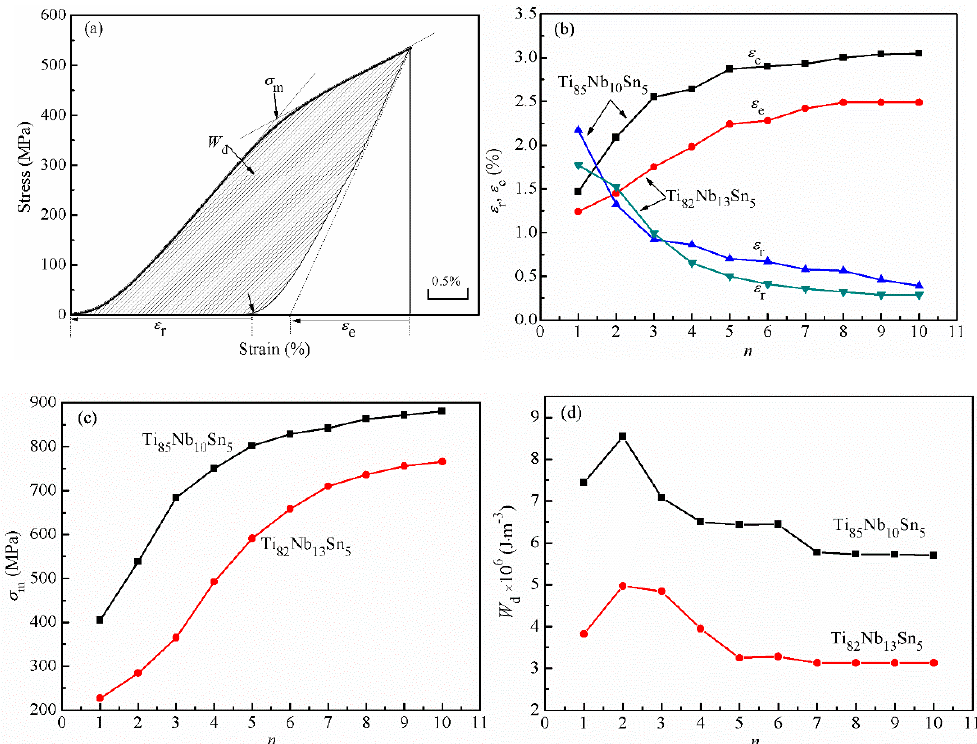
Figure 7. The ( a ) stress-strain curves of Ti 85 Nb 10 Sn 5 alloy under first cyclic loading; the relationship between, ( b ) residual strain ( ε r ) and elastic strain ( ε e ), ( c ) critical stress ( σ m ), ( d ) cyclic dissipation energy ( W d ), and loading times ( n ) for the Ti 85 Nb 10 Sn 5 and Ti 82 Nb 13 Sn 5 alloys.